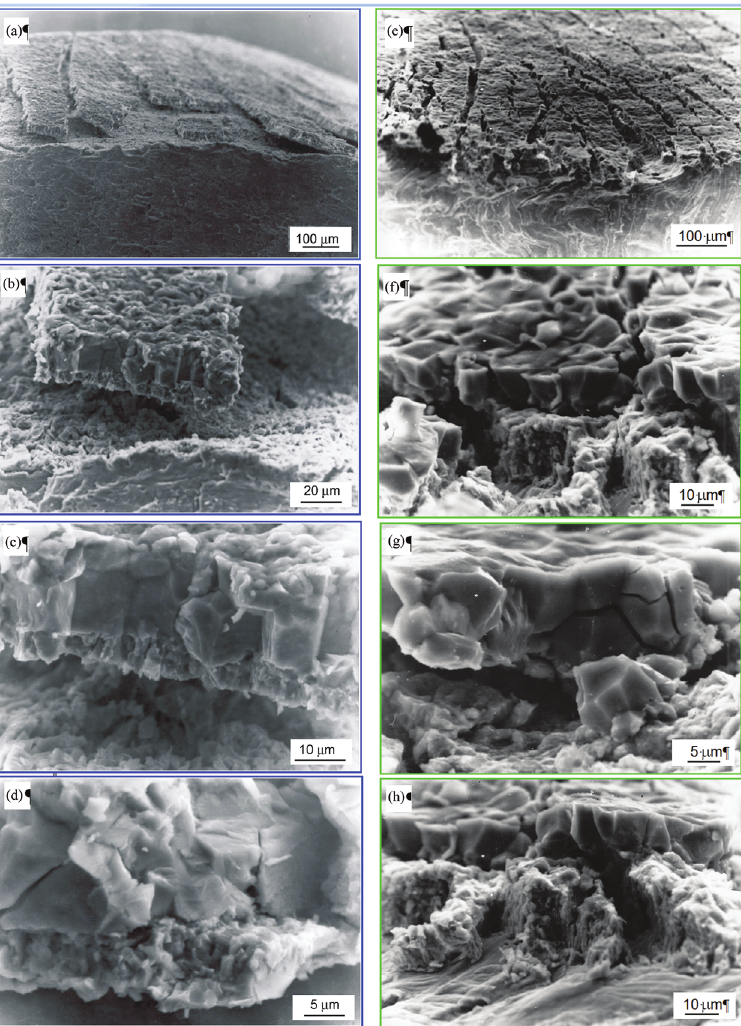
Figure 7: Comparison of the microstructure fractures of the outer and interior zones of the aluminide coatings for the two variants of the CVD process parameters; (a) – (d) blue color: T ¼ 1,050 °C, t ¼ 8 h, p ¼ 150 hPa; (e) – (h) green color: T ¼ 1,020 °C, t ¼ 4 h, p ¼ 150 hPa.